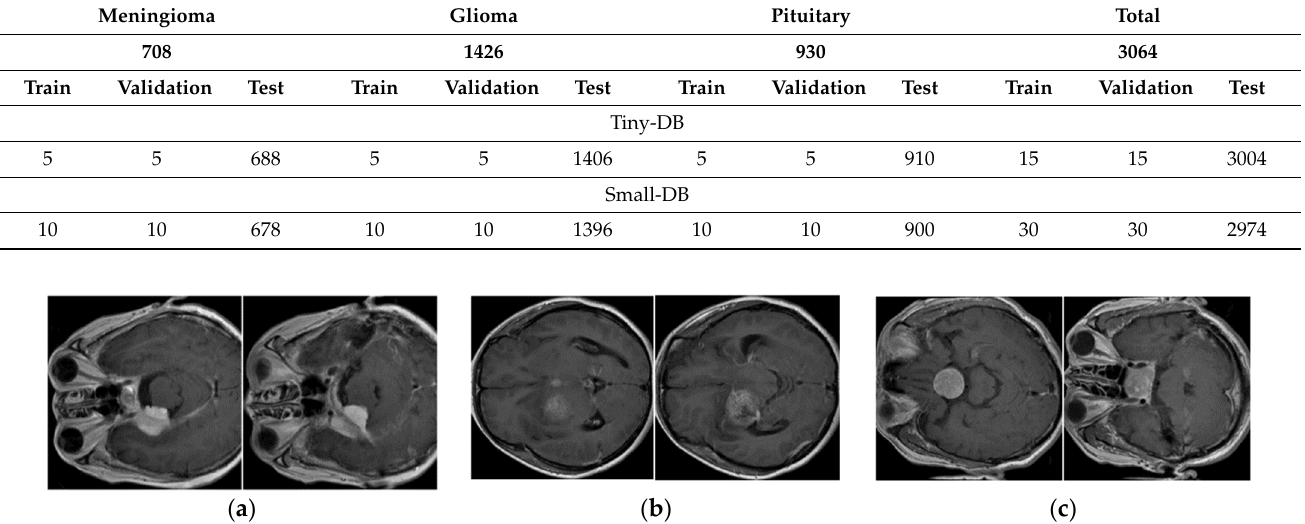
Figure 8. Example of images in the BT-Large dataset: ( a ) Images of meningioma class; ( b ) images of glioma class; and ( c ) images of pituitary class.